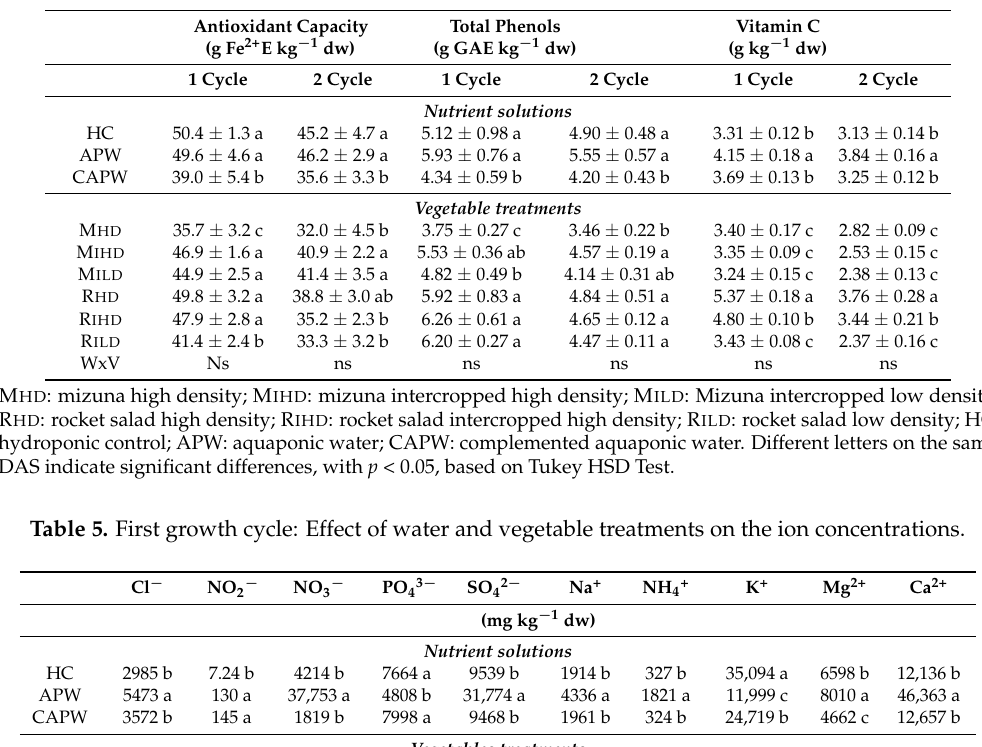
Table 4. Effect of water and vegetable treatments on antioxidant components concentration.